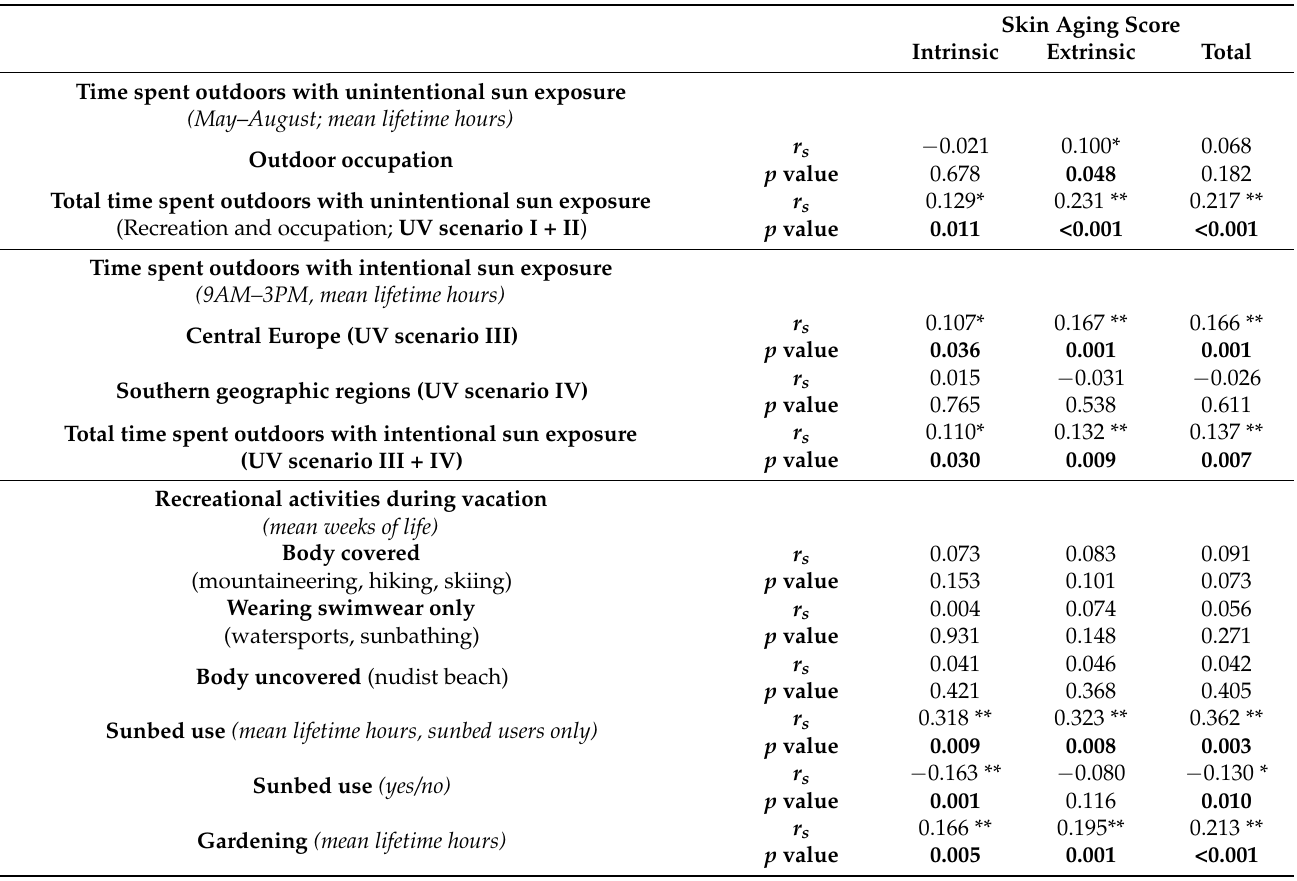
Table 2. Correlations of the skin aging scores with different UV scenarios in the whole study population.